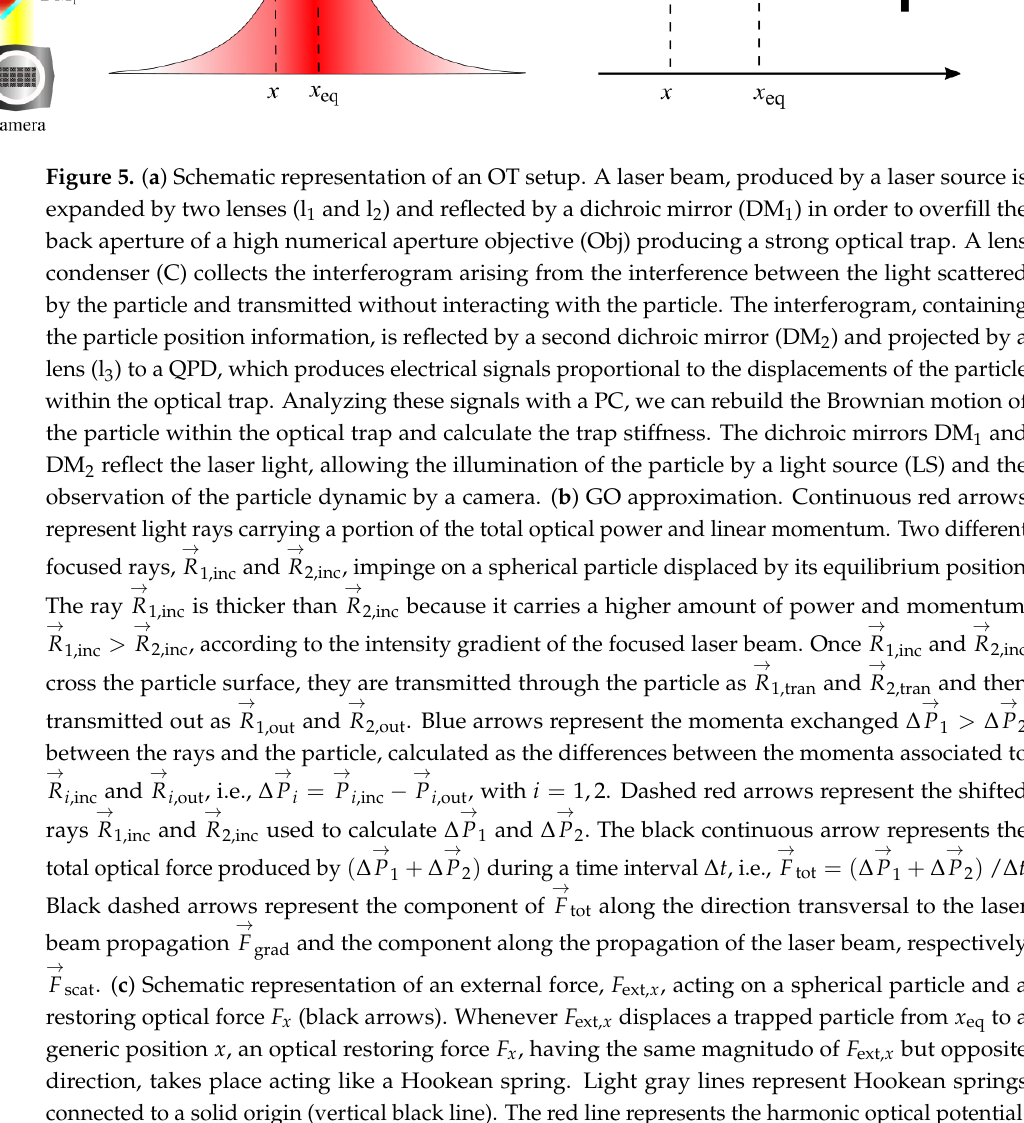
focused laser beam able to exert optical forces on micro and nano-objects as a consequence of the conservation of the linear momentum in the light–matter interaction [156]. Under proper experimental conditions (i.e., laser power, size of the particle and refractive indexes of both during a time interval Δ𝑡 gives rise to an optical force 𝐹 = Δ𝑃⃗ /Δ𝑡 according to the New- the medium and the particle), optical forces are able to confine a particle near the focal spot ton’s second law (Figure 5b). In the GO approximation, the optical force 𝐹 acting on a of a focused laser beam [156]. Figure 5a depicts the main components existing in OT setups. particle is the sum of all the momenta exchanged by all the rays impinging on the particle.